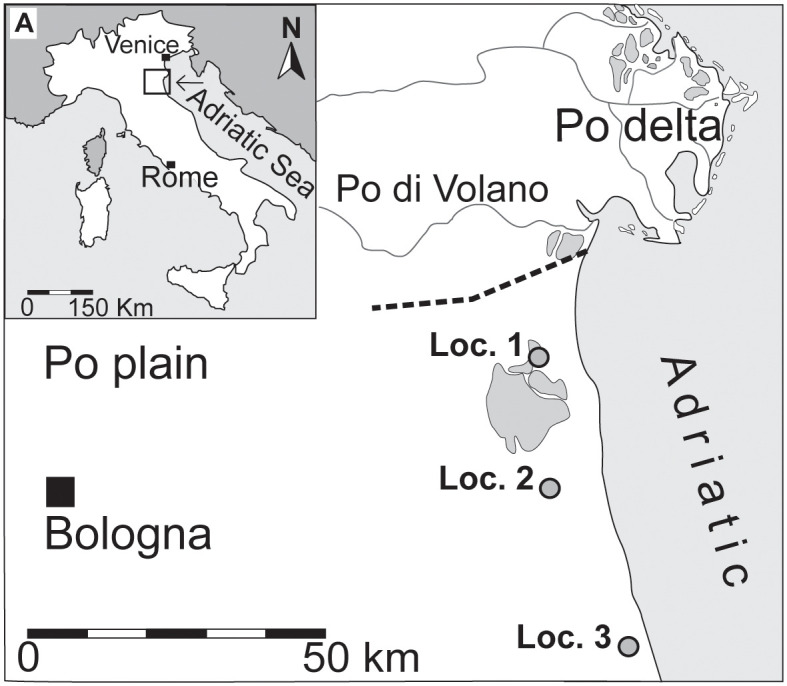
Location map of study (adapted from [16] and for illustrative purposes only).